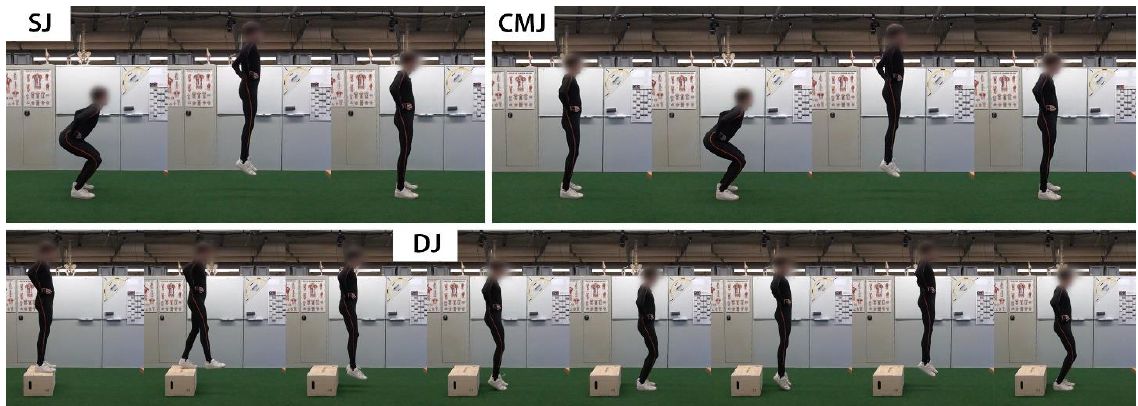
Figure 1. Step-by-step execution of the different high-impact exercises SJ, CMJ, and DJ. The hands must remain on the hips during the entire execution. When landing, ensure as little cushioning as possible through knee flexion. The height of the box at the DJ is 30 cm.